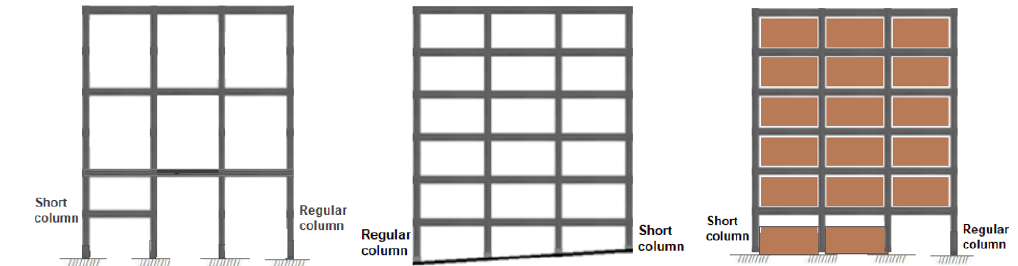
Figure 2. Short column formations.